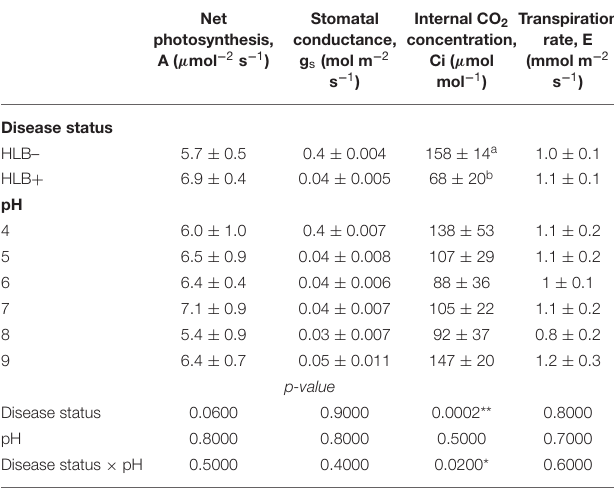
TABLE 3 | Leaf gas exchange of “Ray Ruby” grapefruit ( C. paradisi ) on sour orange ( C. aurantium ) rootstock exposed to different HLB disease statuses [HLB-free or healthy (negative, HLB–) and HLB-affected (positive, HLB + )] under an increasing range of substrate pHs